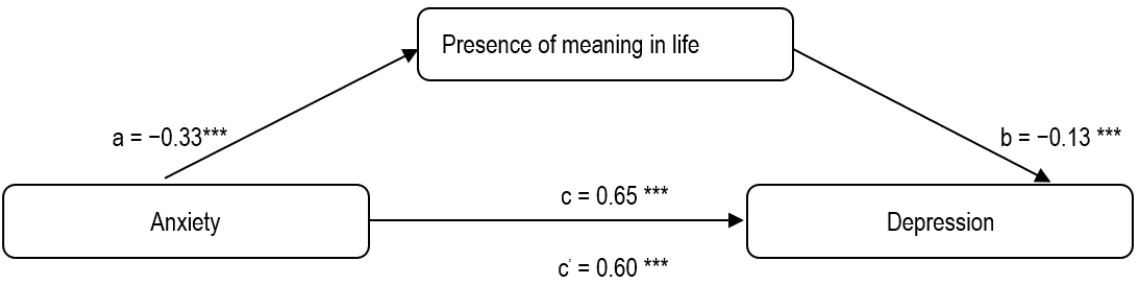
Figure 1. Results of mediation analysis of presence of meaning in life in the relationship between anxiety and depression. *** p < 0.001 .